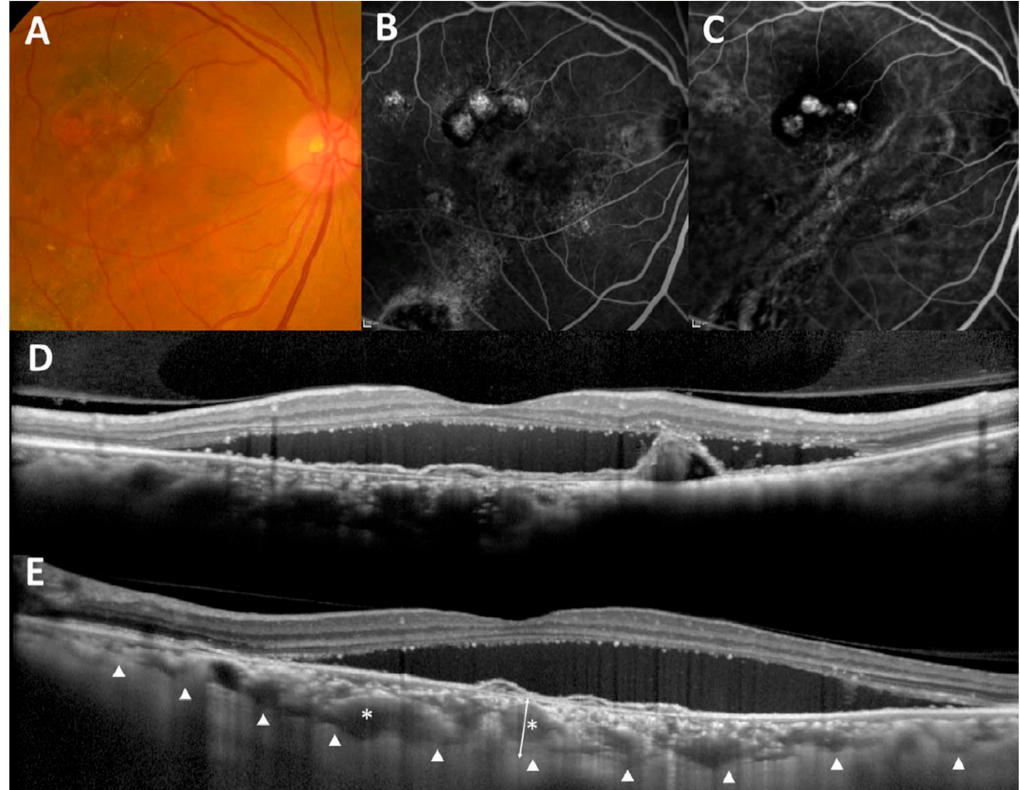
Figure 3. Typical images of pachychoroid neovasculopathy (modified from [149]). Color fundus photography reveals an orange-red nodular lesion, serous retinal detachment, and hard exudates ( A ). Fluorescein angiography reveals a window defect corresponding to RPE atrophy and occult choroidal neovascularization ( B ). Indocyanine green angiography shows choroidal neovascularization and some polypoidal lesions ( C ). A vertical optical coherence tomography (OCT) scan through the fovea shows subretinal fluid and protrusion of retinal pigment epithelium resulting from polypoidal lesions ( D ). A horizontal enhanced depth imaging OCT scan through the fovea shows thickened subfoveal choroidal thickness (triangles) and pachyvessels (asterisks) ( E